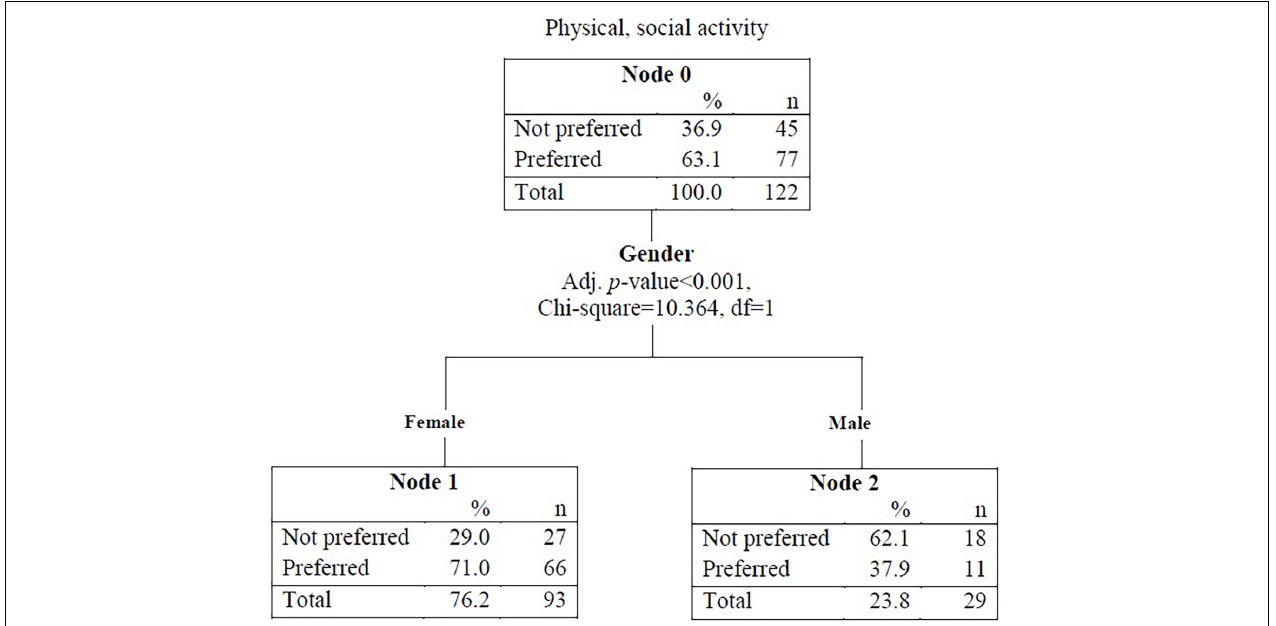
FIGURE 1 | Decision tree for predicting physical and social preference.